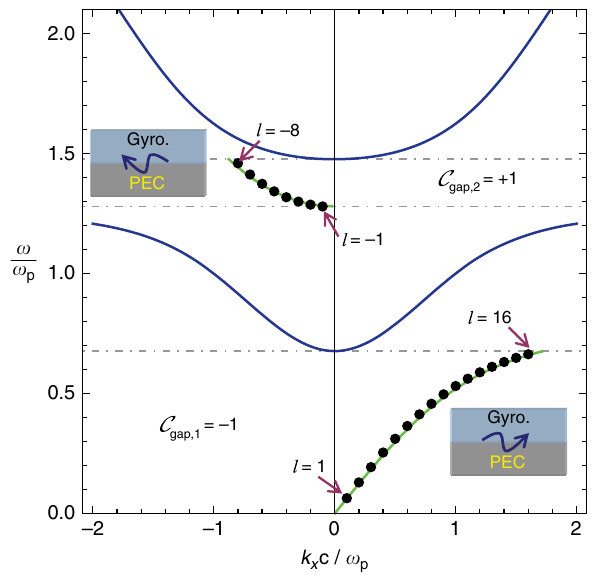
~ L (cid:6) Figure 4a and b depict the normalized spectral density ω L ω c 2 π in the 1st and 2nd band-gaps, respectively, for cavities with E T ; ω A tot radius R ¼ 10 c = ω (dot-dashed green lines) and R ¼ 20 c = ω p p (black lines). As seen, even though the cavity radius is only a few free-space wavelengths, the numerical results are consistent with ~ L Fig. 2 Dispersion of the bulk modes and of the edge waves. Blue lines: band (cid:2) (cid:3)C ¼ þ 1 in the 1st gap and the approximate identity (4): ω ω ¼ 0 : 8 ω ~ L diagram of the bulk gyrotropic material with ω . The two photonic (cid:2) (cid:3)C ¼ (cid:3) 1 in the 2nd gap. In R → ∞ limit the approximate c p ω ω band-gaps are delimited by the dashed horizontal grid lines. The gap Chern identities become exact, and the angular momentum spectral numbers ( C and C ) are given in the insets. Green lines: dispersion of gap ; 1 gap ; 2 density is exactly quantized and is determined by the gap Chern the (gap) edge modes supported by a planar interface ( y = 0) between the ~ L ~ L ¼ (cid:3)C ¼ (cid:3)C numbers: in the 1st gap and in the ω ω gyrotropic material (region y > 0) and PEC material (region y < 0). The edge gap ; 1 gap ; 2 2nd gap (dashed blue lines in Fig. 4). modes propagate along the x -axis (see the insets). The edge mode dispersion is shown only in the band-gaps. Discrete black symbols: resonant frequencies of a cylindrical cavity ( R ¼ 10 c = ω ) with PEC walls p fi lled by the gyrotropic material. The modes are labeled by the